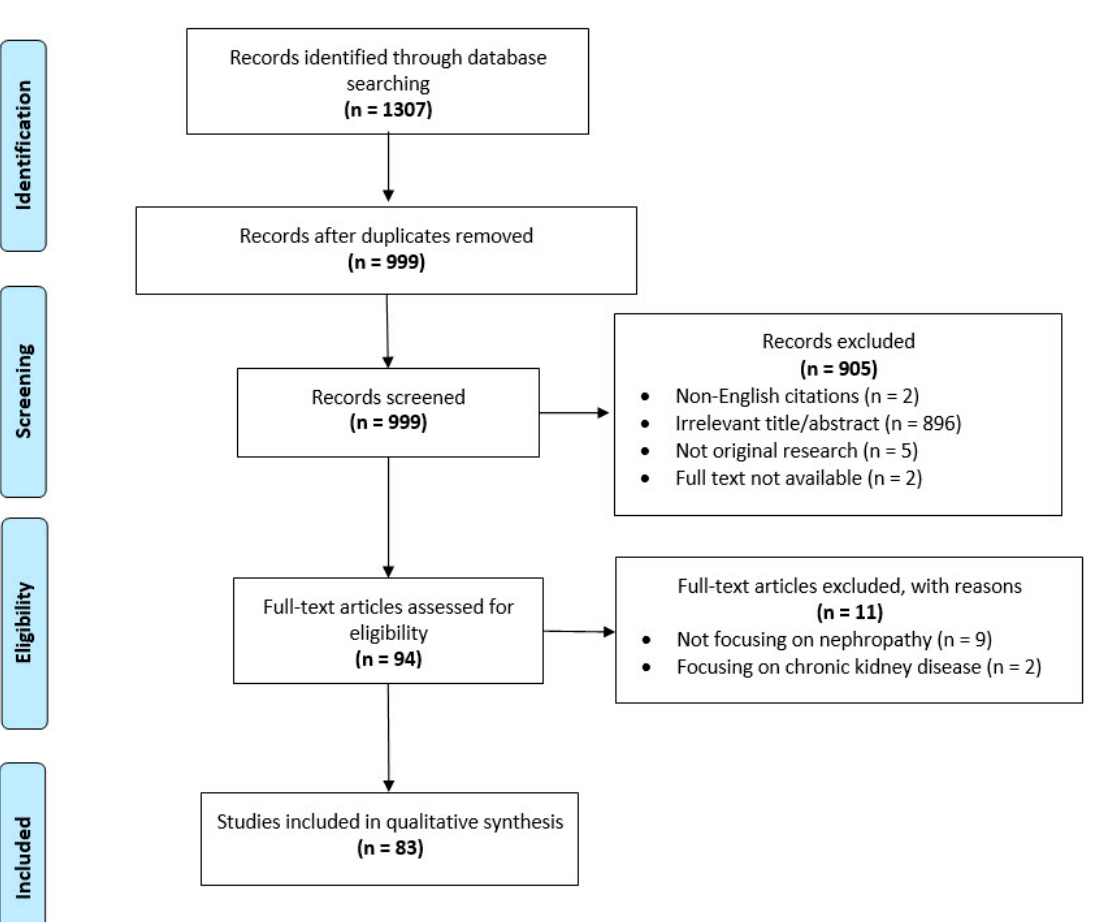
Figure 2. PRISMA flow chart showing the study selection procedure.